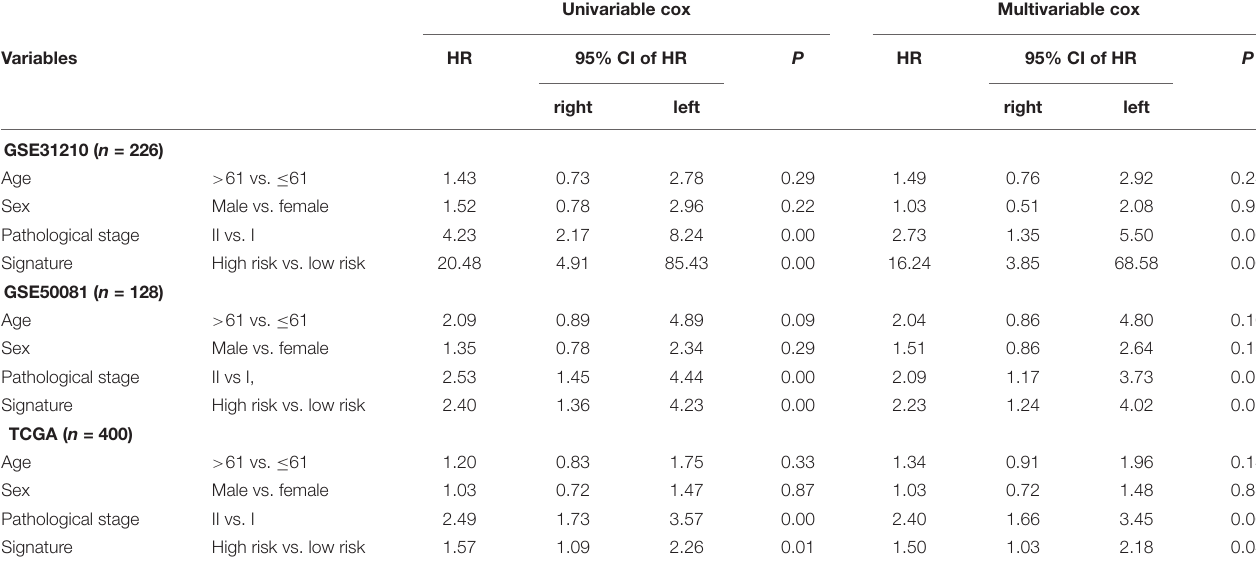
TABLE 4 | Univariable and multivariable Cox regression analysis of the signature and clinical information with lung adenocarcinoma (LUAD)